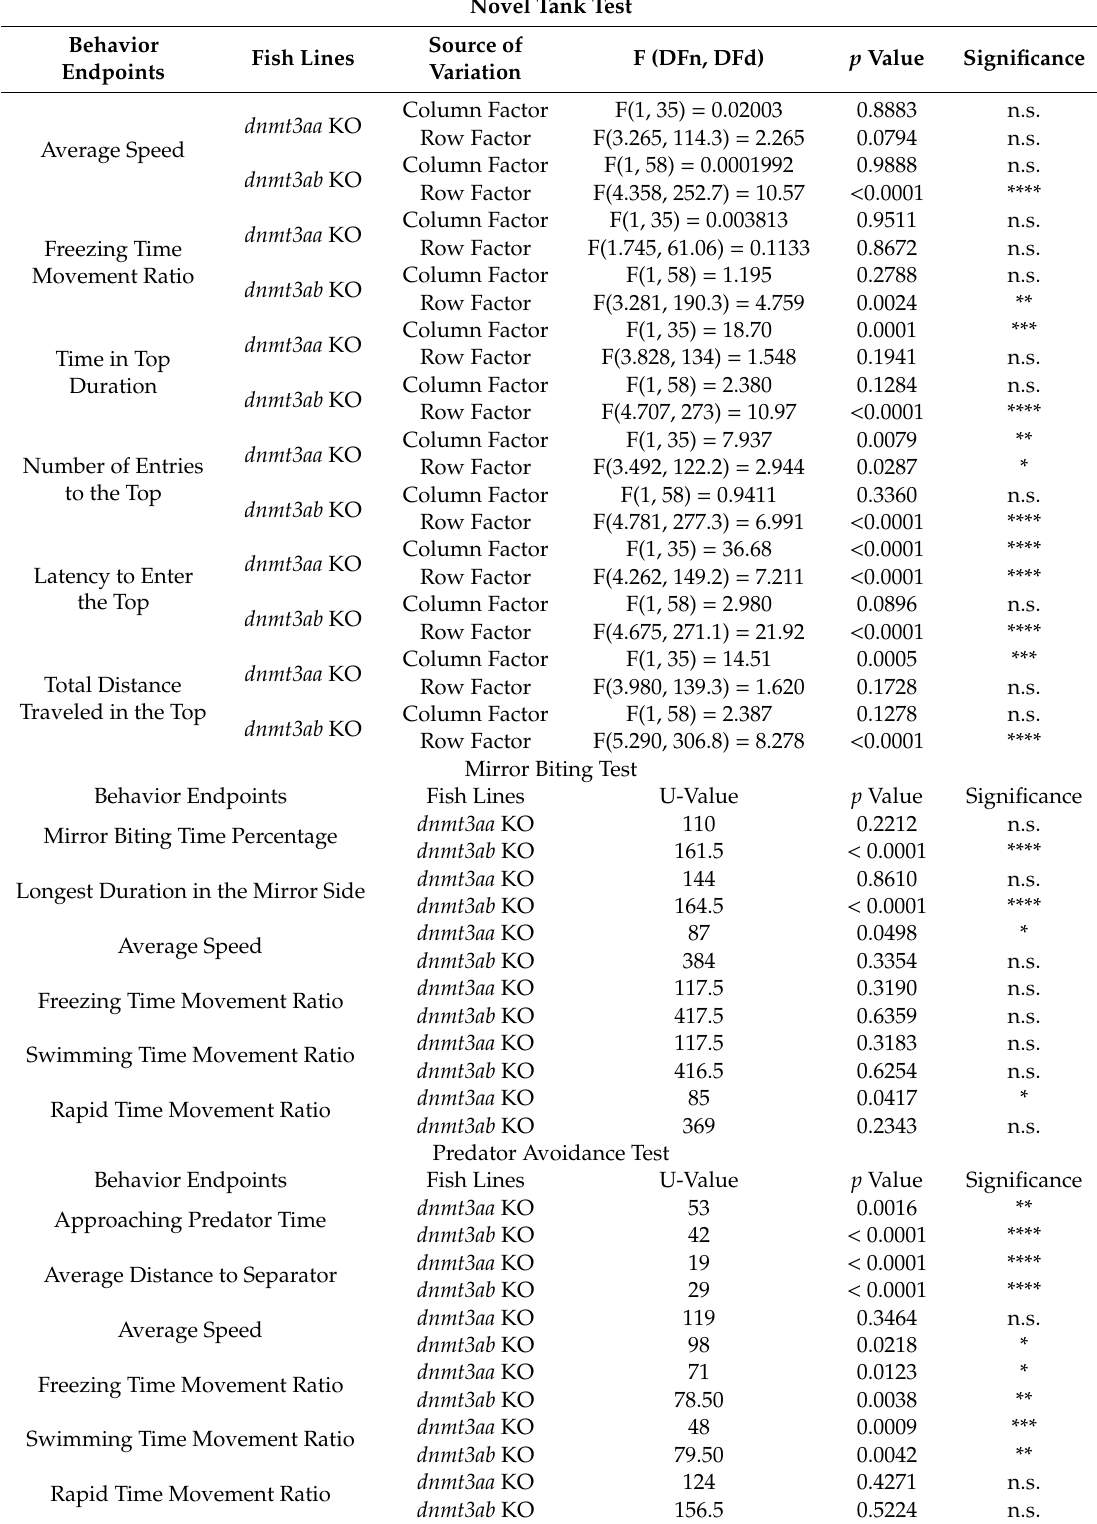
Table A1. The statistic details of each statistic test from each data (Column Factor = fish line factor, Row Factor = time interval factor, n.s. = not significant, * p < 0.05, ** p < 0.01, *** p < 0.001, **** p <